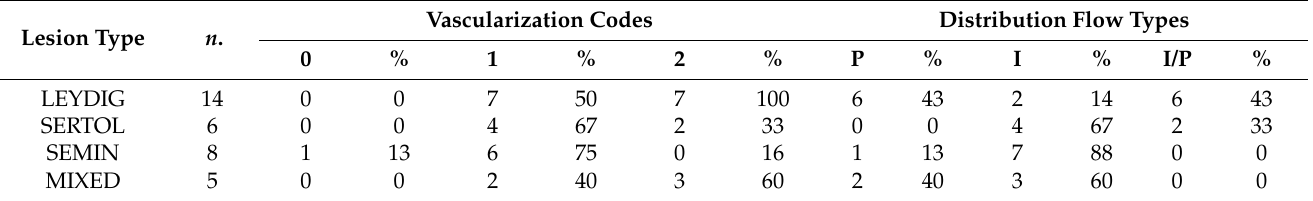
Table 5. B-Flow characterization (numbers and relative frequencies) of arterial vascularization and arterial distribution in different tumor lesions ( n = 33) included in the comparative analysis. The arterial vascularization was categorized as 0, 1 or 2 if absent, smaller or larger than 2 mm in diameter respectively; the arterial distribution was classified as P if the vessels were perilesional or I if distributed within the tumor lesion and I/P if both